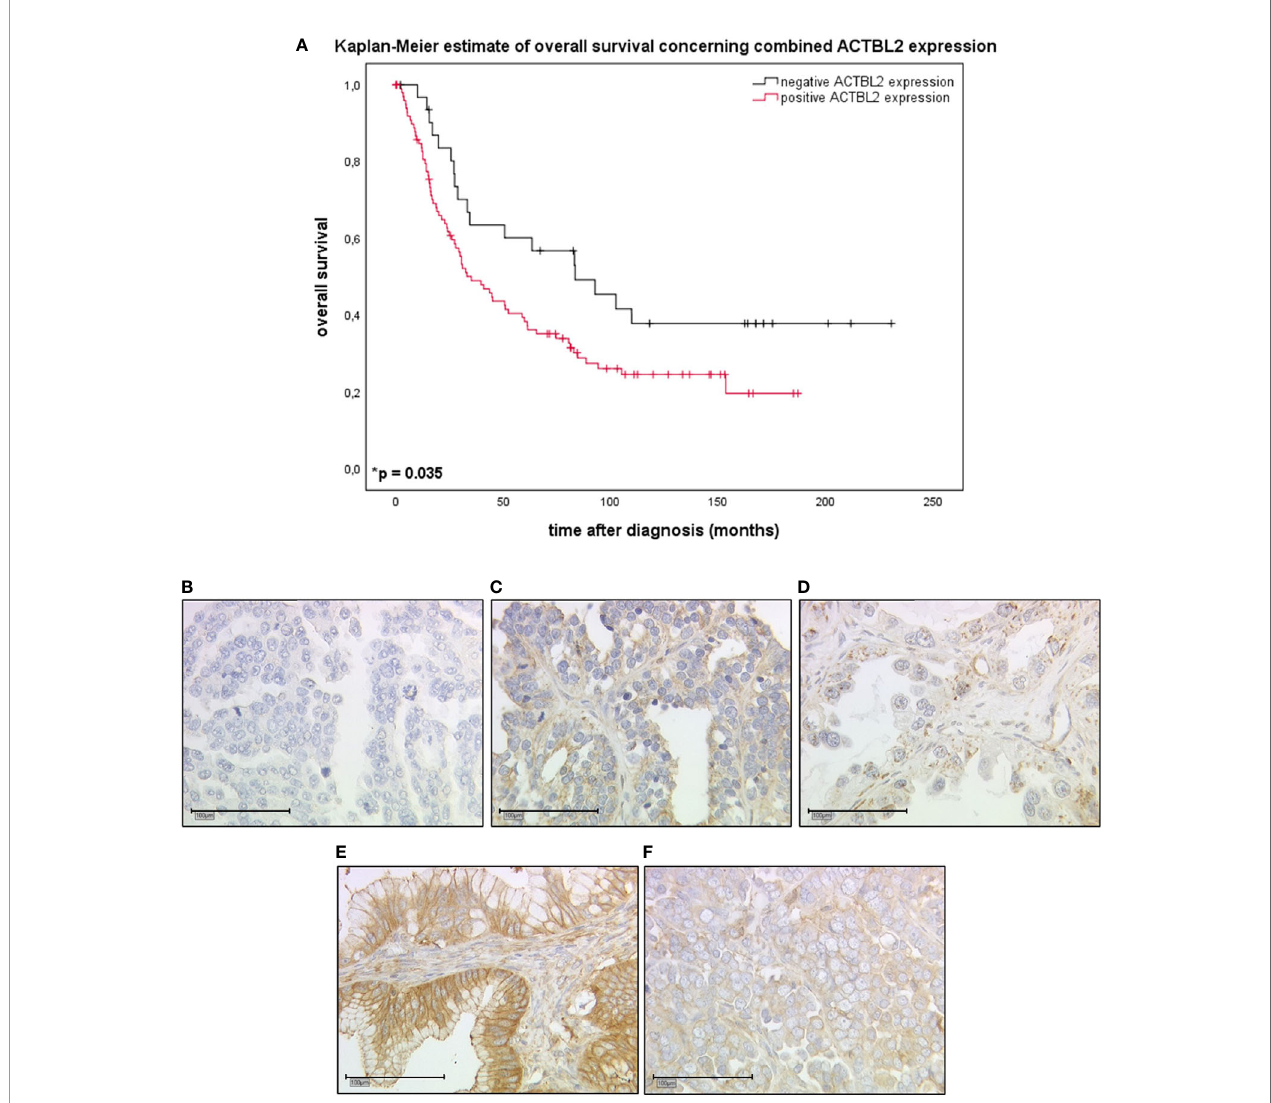
FIGURE 1 | Kaplan-Meier estimate of combined ACTBL2 expression in EOC patients as detected by immunohistochemistry. (A) Kaplan-Meier estimate (log-rank testing) concerning combined cytoplasmic (IRS>2) and membranous (IRS>0) ACTBL2 expression in epithelial ovarian cancer, being associated with impaired overall survival (median OS 35.2 vs . 83.4 months; p =0.035). Censoring events were marked in the graphs (+). (B – F) Detection of ACTBL2 by immunohistochemistry. Exemplary photographs (25x magni fi cation; scale bar=100µm), showing the differences between ACTBL2-negative (B) and ACTBL2-positive tissue of all histological subtypes of EOC (C – F) , thus visually supporting the survival analysis displayed above: (B) serous carcinoma, cytoplasmic IRS=0, membranous IRS=0; (C) serous carcinoma, cytoplasmic IRS=4, membranous IRS=4; (D) clear cell carcinoma, cytoplasmic IRS=4, membranous IRS=1; (E) mucinous carcinoma, cytoplasmic IRS=8, membranous IRS=8; (F) endometrioid carcinoma, cytoplasmic IRS=8, membranous